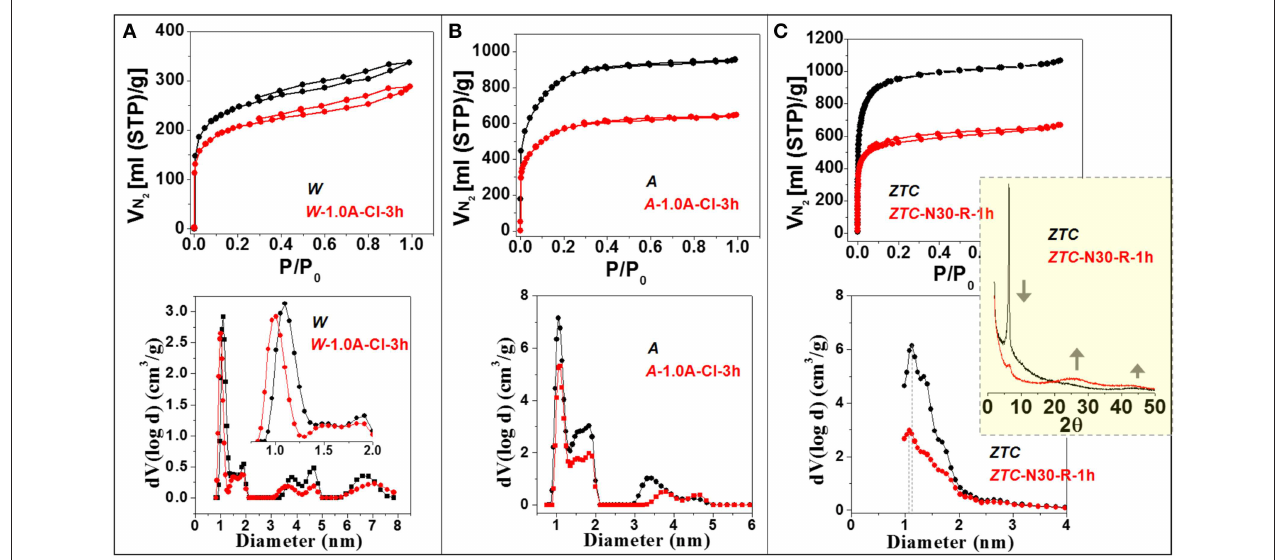
FIGURE 3 | N 2 adsorption-desorption isotherms at − 196 ◦ C and the DFT-derived pore size distributions of the studied W (A) , A (B), and ZTC (C) microporous materials compared to those of a representative highly-oxidized material obtained after 3 h-treatment at 1.0A in 2 wt% NaCl (A,B) or 1 h-oxidation with 30 wt% HNO 3 (C) at room temperature. Inlet of (C) : X-ray diffractograms of ZTC before and after oxidation.